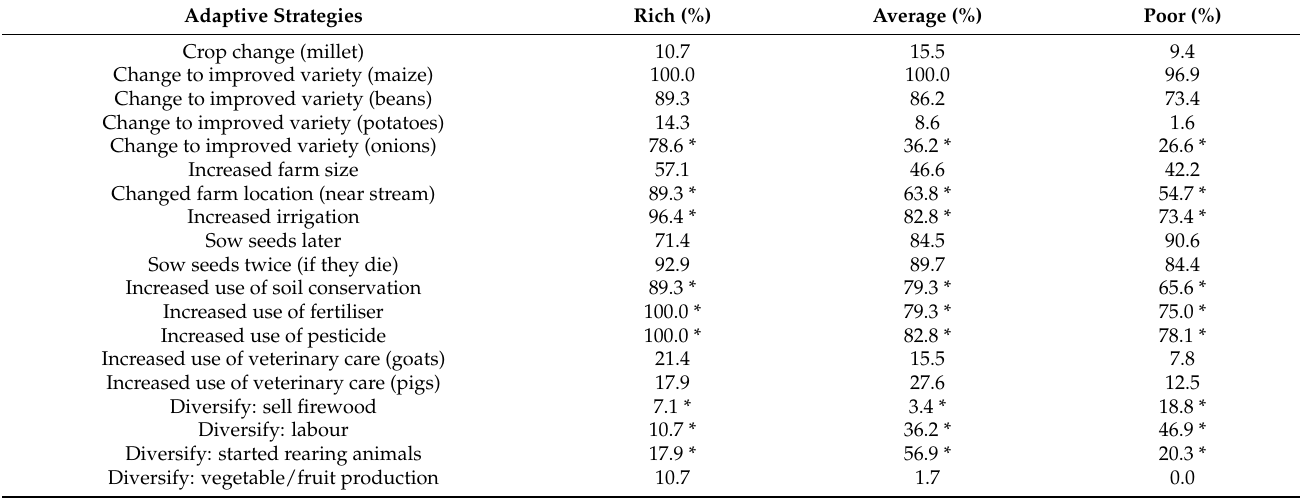
Table 2. Adaptive strategies used by each wealth group on Udzungwa Mountains (% respondents within wealth group). * Significant differences across wealth groups at p > 0.05, using cross-tabulation tables and chi-square tests. Adaptive Strategies Rich (%) Average (%) Crop change